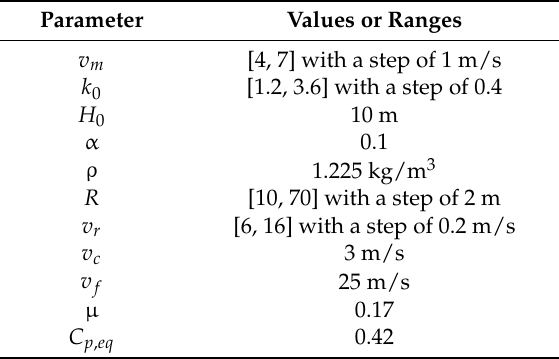
Table 5. Parameters used in the proposed COE minimization method.